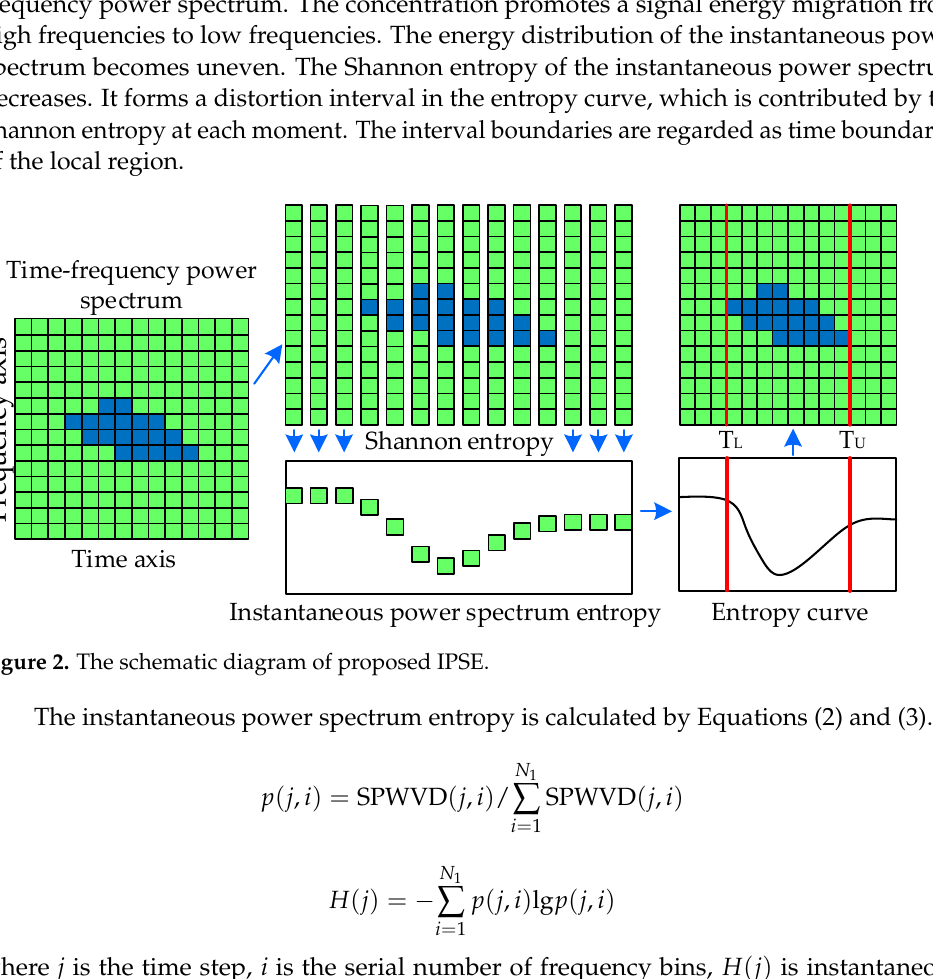
F 1 Figure 3. The schematic diagram of proposed STNED.